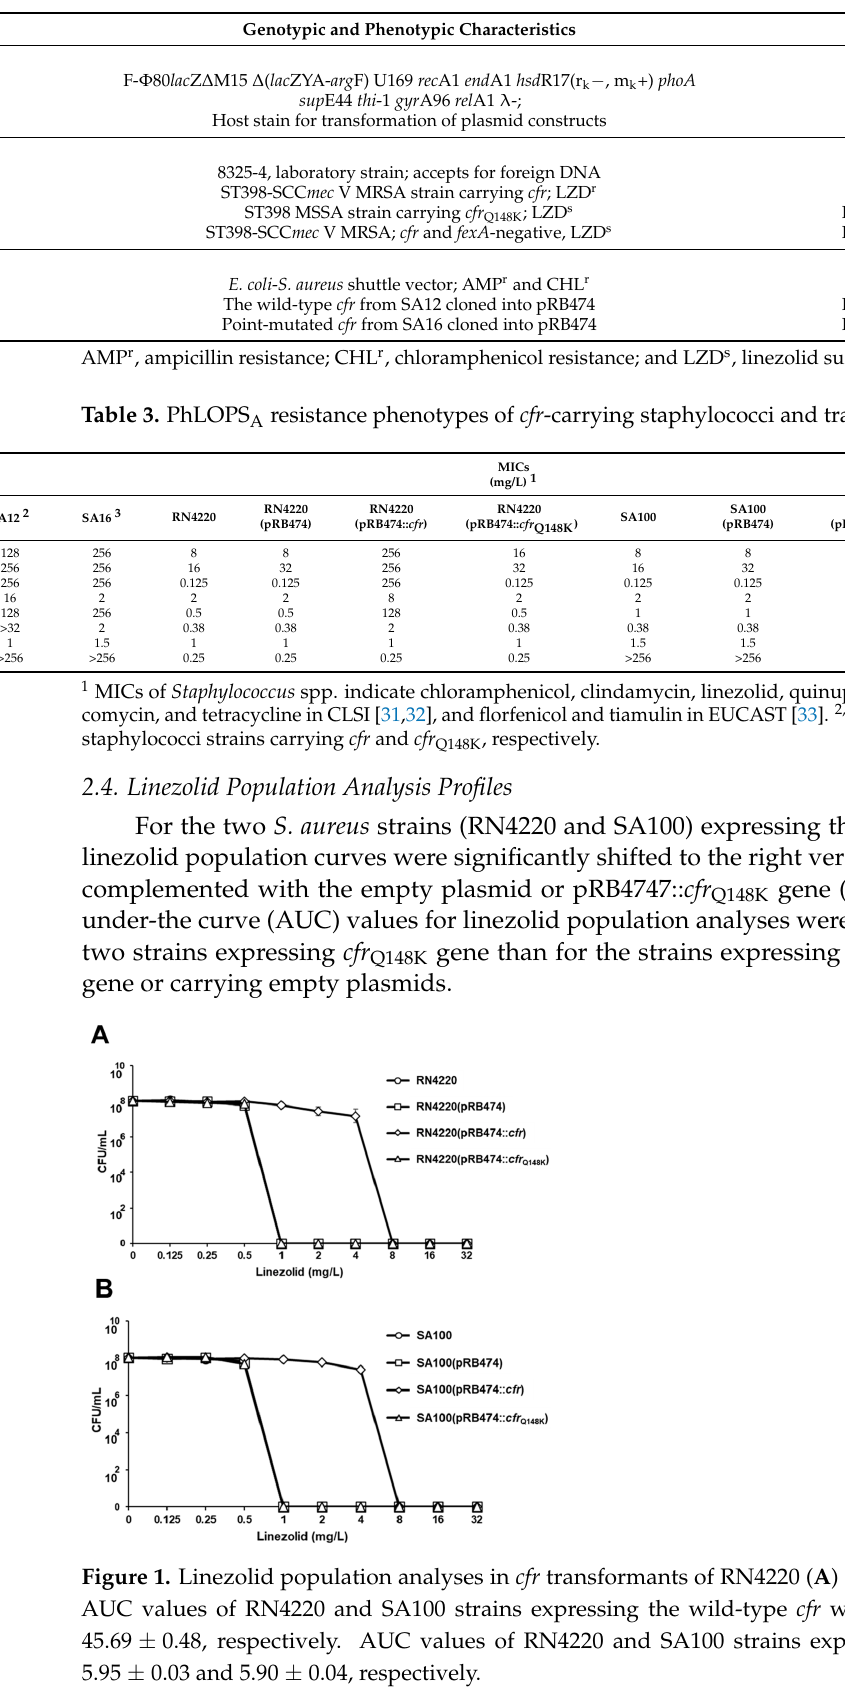
Four cfr -positive linezolid-susceptible staphylococcal strains (SA16, SA19, SE10, and SSC2) were selected for comparative analysis of the genetic regions harboring the cfr Q148K genes. Genome sequence data indicated that the all cfr -positive strains possessed 38-kb plasmids (pSA16, pSA19, pSE10-1, and pSSC2-1) carrying cfr Q148K genes. As shown in Fig- ure 2, the identical structures of the cfr Q148K containing regions flanked by the Tn558 trans- poson elements were found on the pSA16, pSA19, pSE10-1, and pSSC2-1 plasmids. BLASTn analysis showed that the 10-kb cfr-carrying segments of S. aureus (SA16 and SA19), S. epidermidis (SE10), and S. sciuri (SSC2) strains shared 99.9% nucleotides sequence identities. The cfr Q148K harboring regions showed 99% nucleotide sequence identities with the previously reported wild-type cfr -carrying plasmid pSA12 (CP049977) of a linezolid- resistant ST398 MRSA strain SA12, except for sequence variations in transposon elements ( tnpA and tnpB ). In addition, fexA genes flanked by the Tn 558 transposon elements were co-located in the downstream of cfr Q148K . Genetic analysis revealed that the fexA genes identified in this study were 100% identical in nucleotide sequence identity to those in the pSA12.